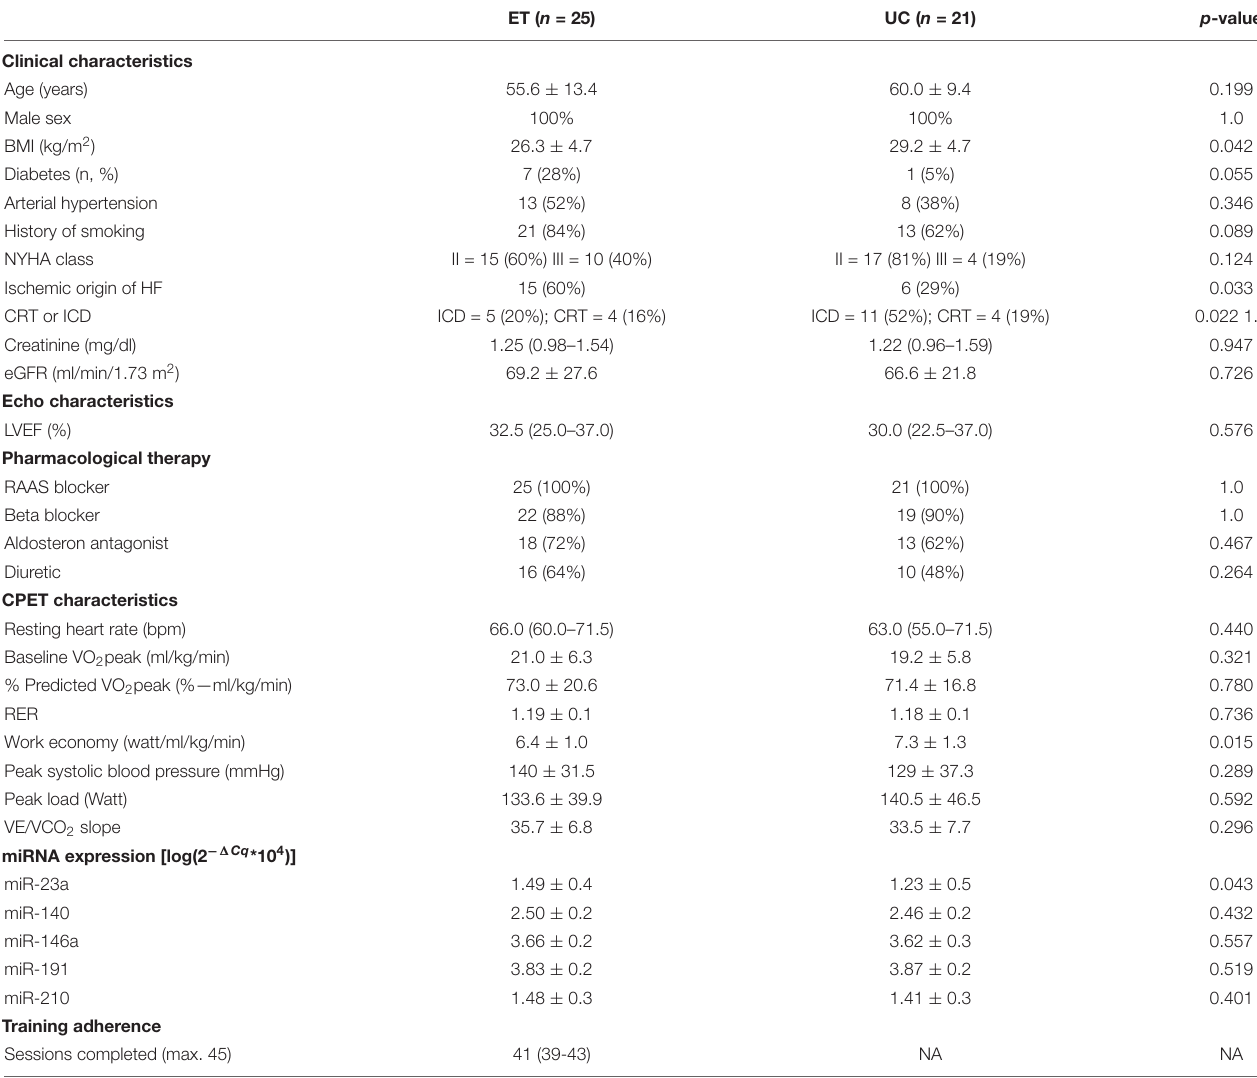
TABLE 1 | Baseline patient characteristics and training